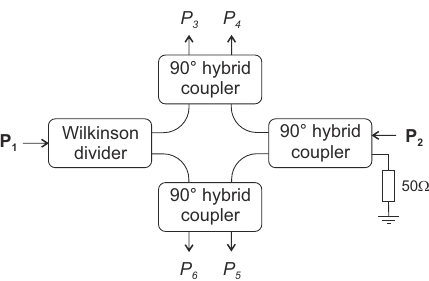
Figure 11. Passive structure of a six-port interferometer formed by a Wilkinson power divider and three 90° hybrid